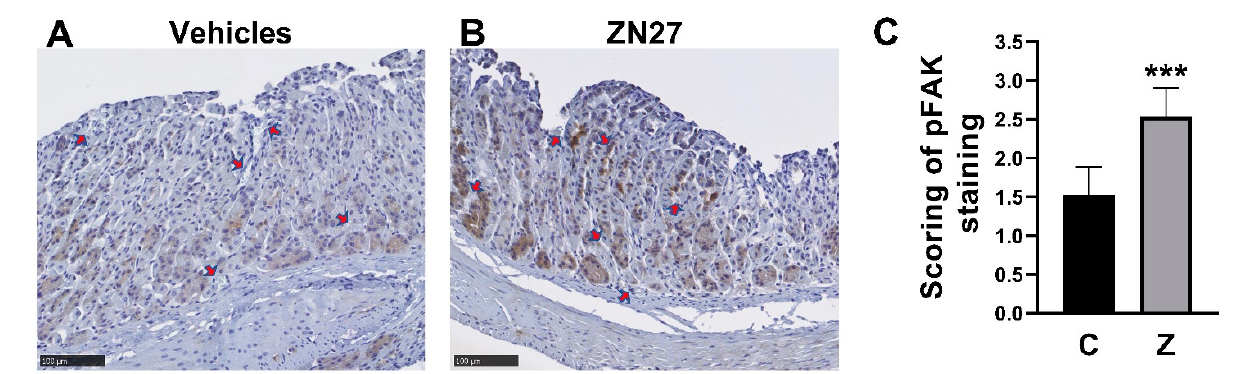
Figure 4. ZN27 increases the immunoreactivity of FAK-Y-397 in the aspirin-induced gastric injury model. ( A ) Representative immunohistochemical images of FAK-Y-397 phosphorylation at the edge of gastric lesions in mice receiving vehicles. ( B ) Representative immunohistochemical images of FAK-Y-397 phosphorylation at the edge of gastric lesions in mice receiving ZN27. Dark brown staining indicates FAK-Y-397 immunoreactivity. Arrows indicate gastric lesions (hyperemia). Scale bars, 100 µm. ( C ) Blindly scored immunoreactivity for FAK-Y-397 increases in ZN27 treated lesions ( n = 7) vs. vehicle-treated lesions ( n = 5), (*** p < 0.001). Vehicles (C), ZN27 (Z).